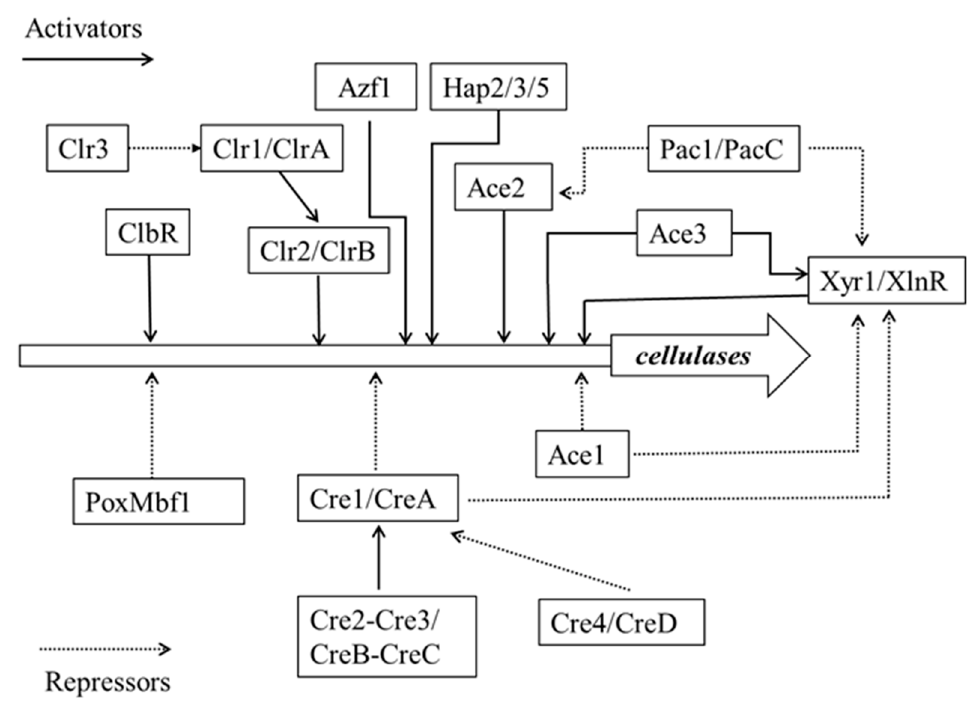
Figure 1. Schematic diagram of a transcriptional regulatory network of genes encoding cellulolytic enzymes in fungi. The solid line with arrowhead represents activated gene expression. The dotted line with arrowhead represents suppressed gene expression.